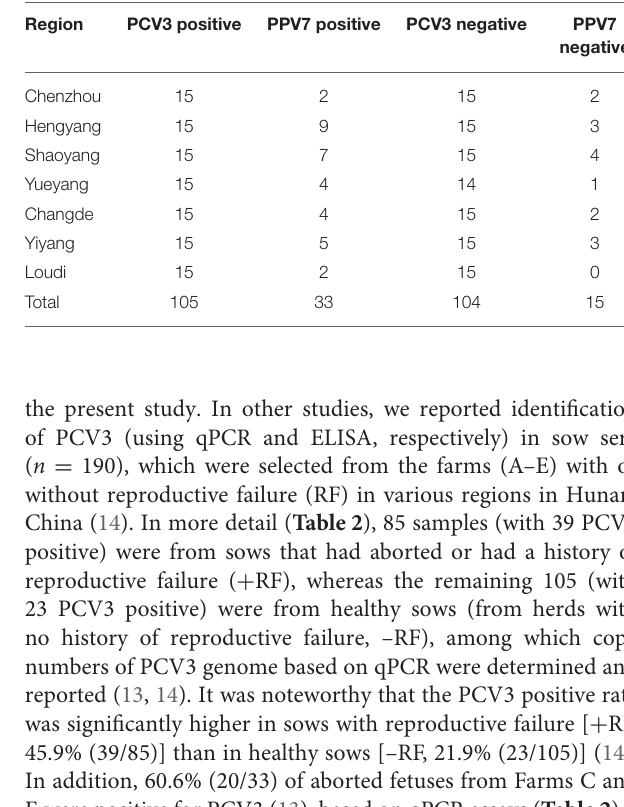
TABLE 1 | Presence of PPV7 in PCV3 positive and negative serum